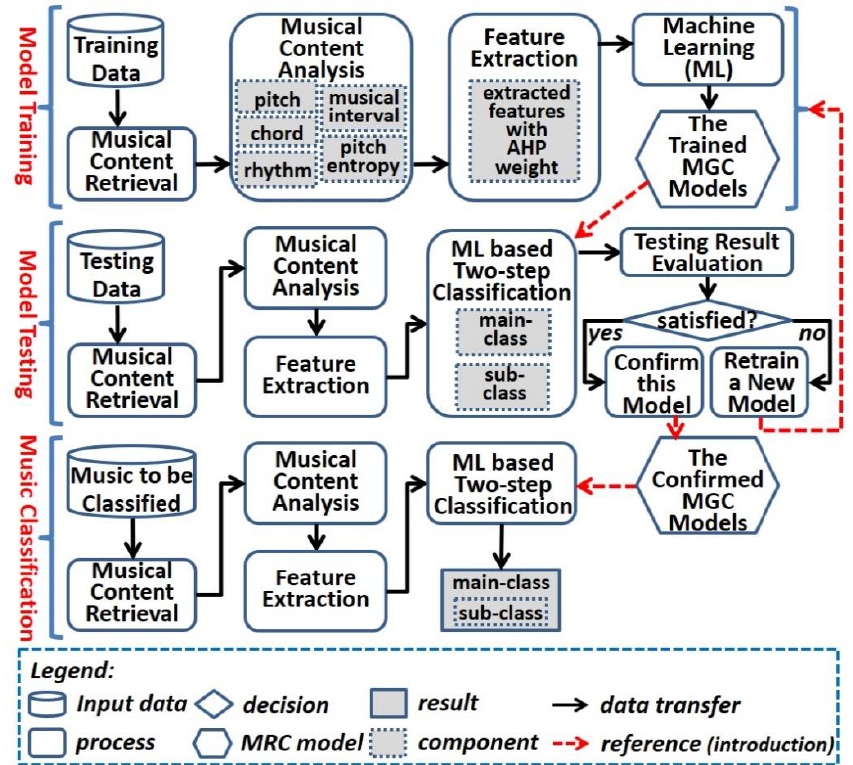
Figure 1. The procedure of the two-step approach for music genre classification (called TSMGC) operation. MCR: musical content retrieval; MGC: music genre classification.